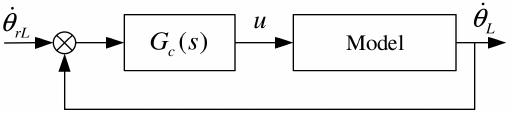
Figure 15. PI speed control system.